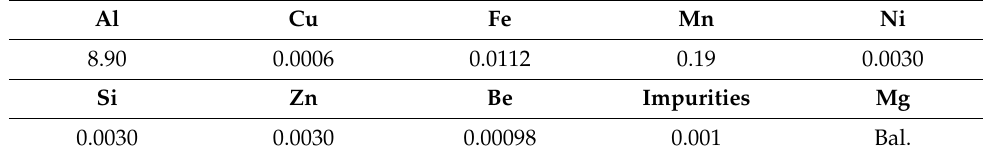
Figure 2. SEM micrograph of the AZ91D matrix. Table 1. Composition of the AZ91D alloy (mass fraction, %).